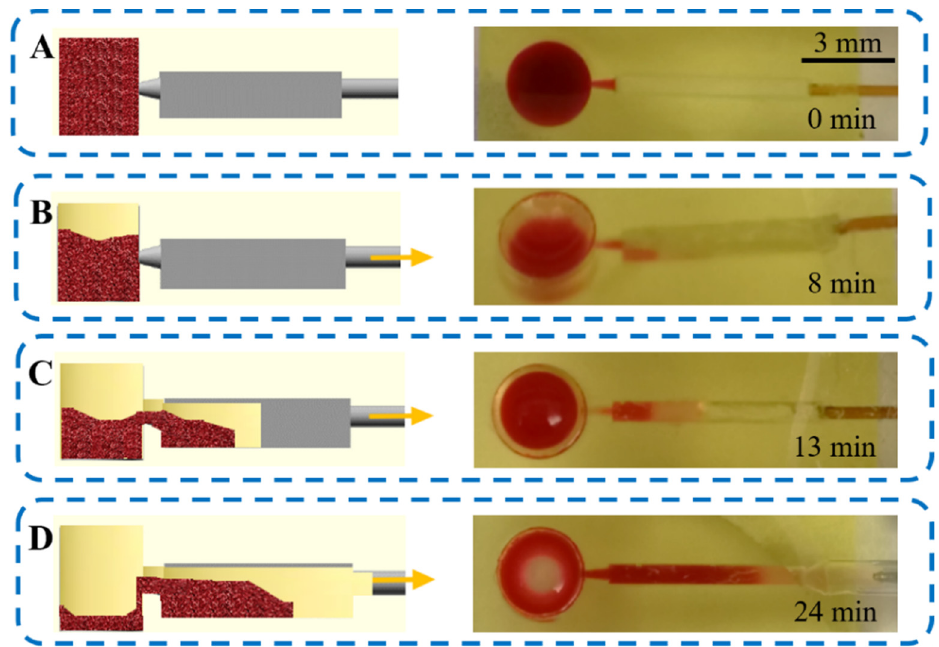
Figure 5. Workflow for plasma separation, showing a schematic diagram (side view) and top ‐ view photos of the 3D ‐ printed Device 15 during each step of the process. ( A ) First, 12 µL of whole human blood was loaded in the input reservoir and let stand for 8 min. ( B ) Then, negative pressure (yellow arrow) was applied at a constant flow of 1 µL min − 1 and the sample entered the sedimentation trench. ( C ) Blood cells sedimented to the bottom whereas plasma was separated due to its lower density. ( D ) Finally, the plasma was collected from the outlet to be further analyzed.